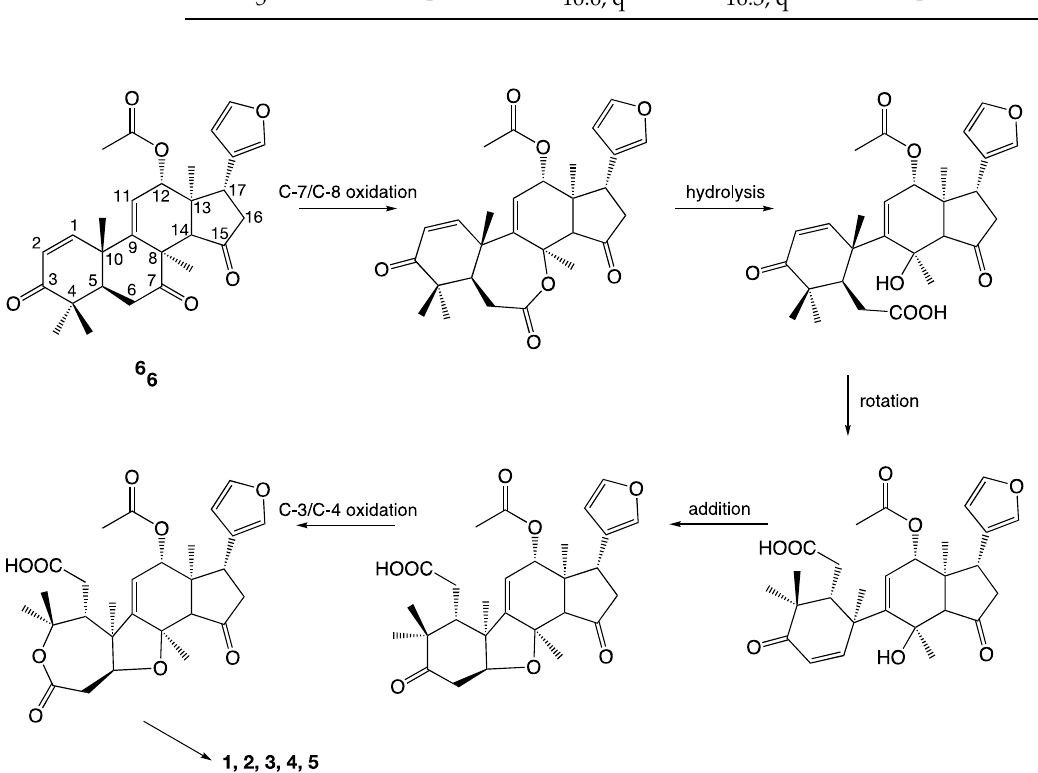
Figure 6. A possible biogenesis of compounds 1 – 5 .